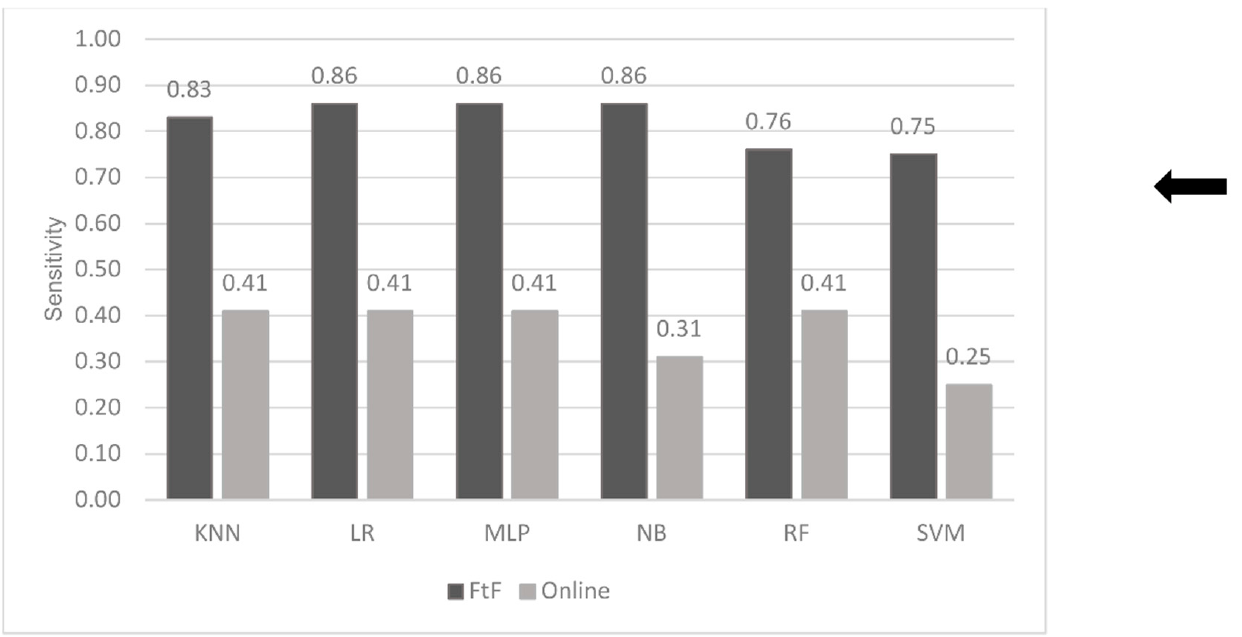
Figure 4. WCO course: prediction of at ‐ risk students (sensitivity scores) by instructional mode.